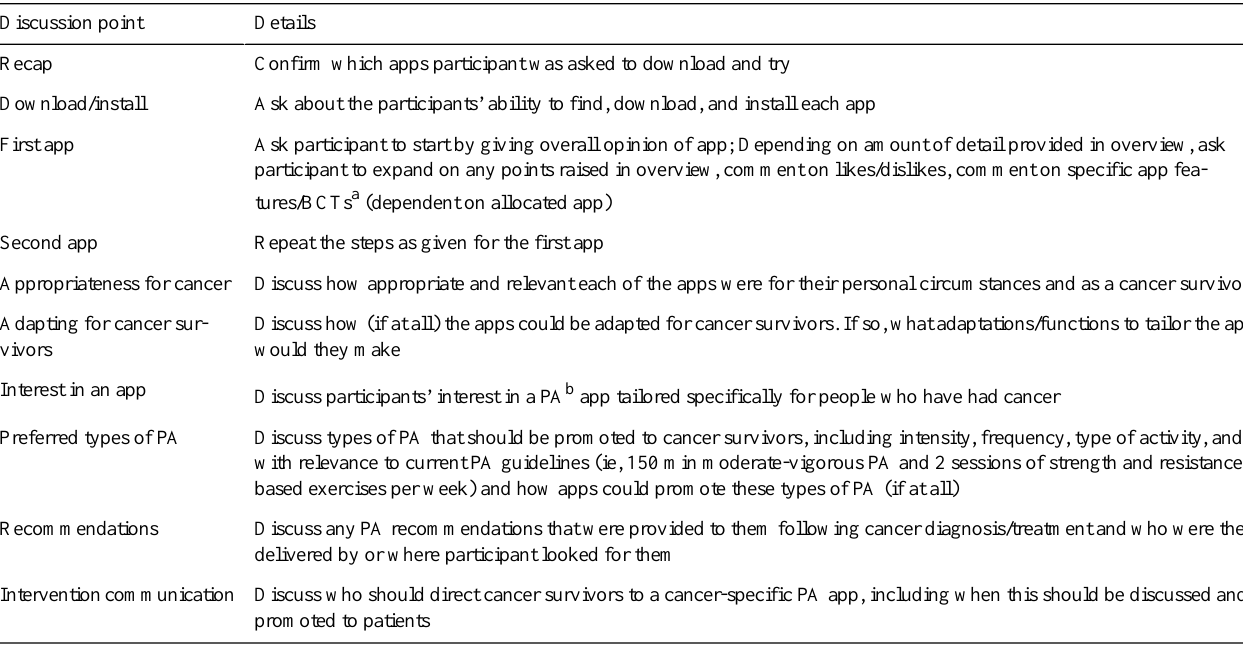
Table 2. Semistructured interview